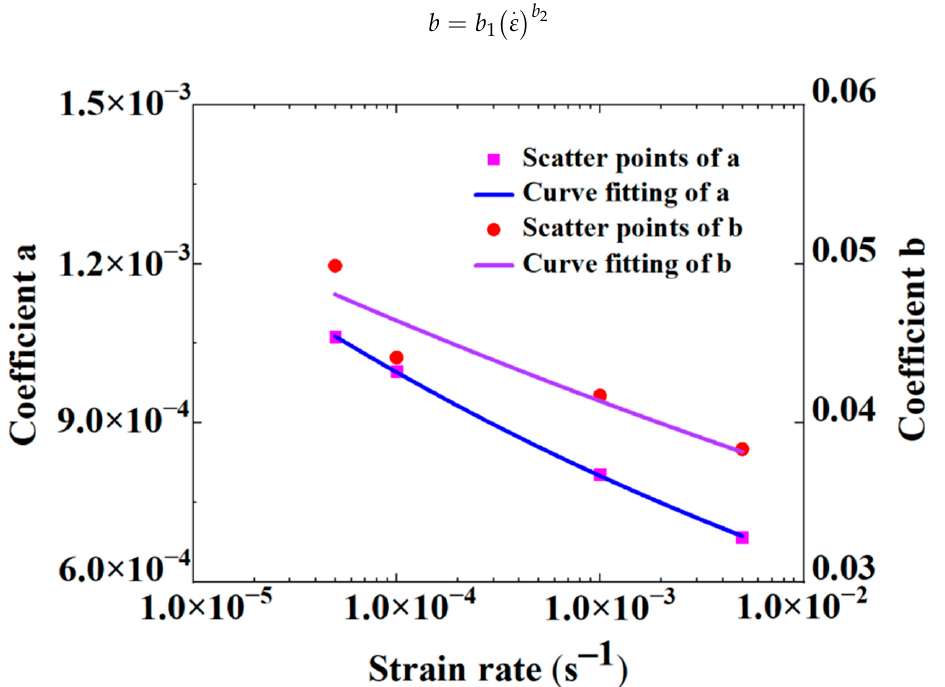
(4) Table 1. Fitting parameters of stress–strain curves. Strain Rate